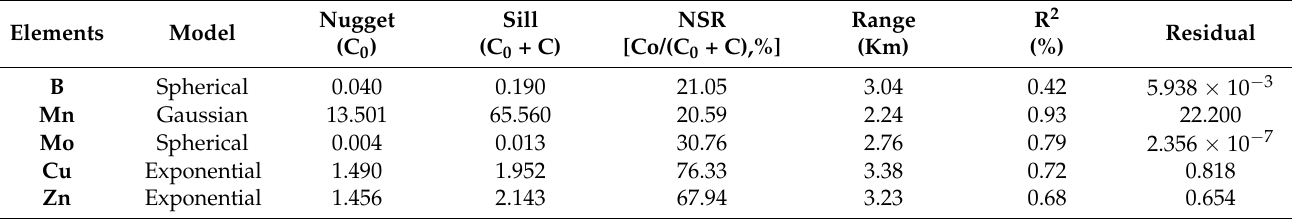
Table 3. Semi variance function parameters of GWR prediction model for soil trace